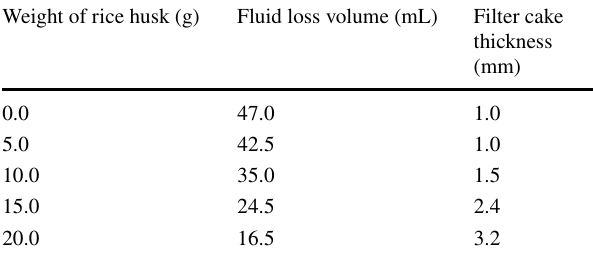
Table 5 Rice husk impact as an additive to drilling fluid Weight of rice husk (g) Fluid loss volume (mL) Filter cake